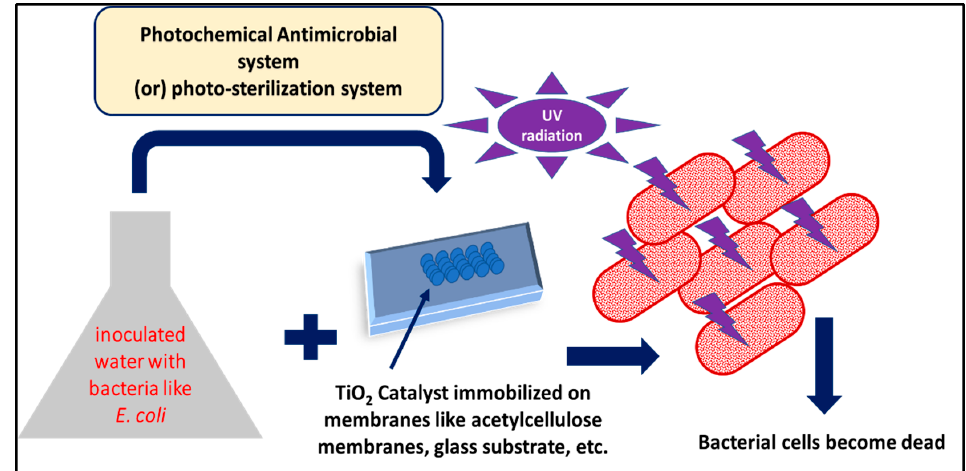
Figure 7. Simple experimental scheme for photochemical antimicrobial mechanism of TiO 2 catalyst.